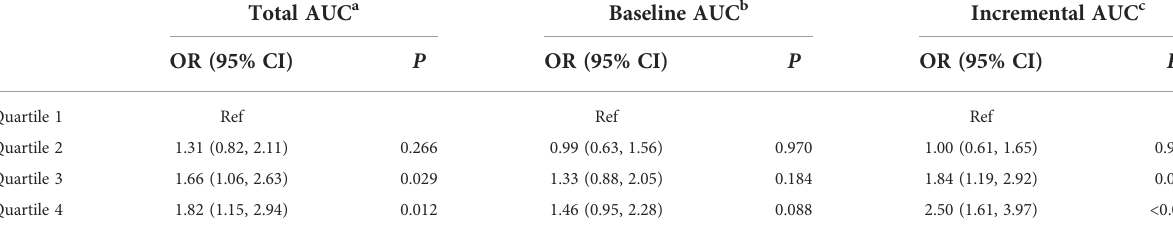
TABLE 4 SBP AUC-odds ratios and 95% CIs for incident